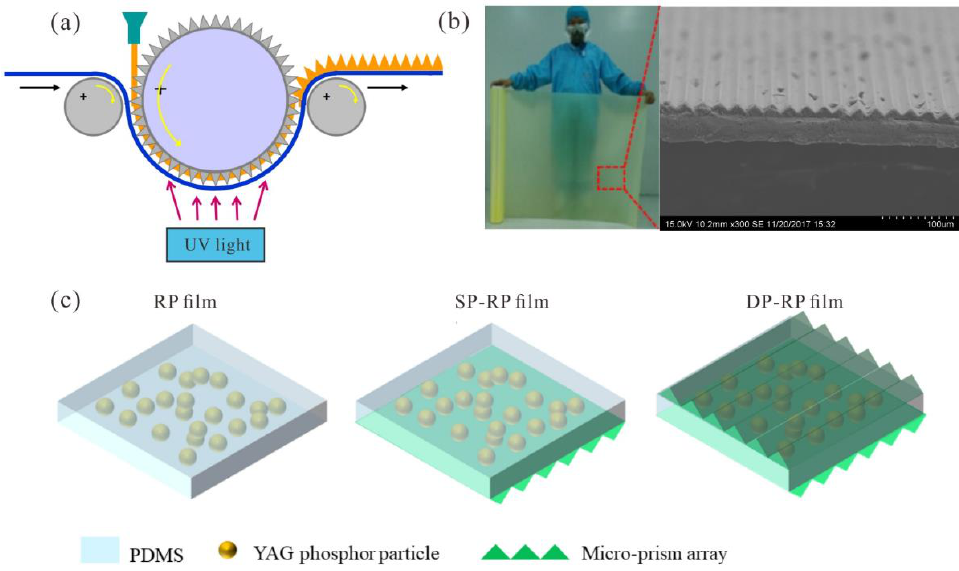
Figure 1. ( a ) Schematic diagram of roll-to-roll imprinting process; ( b ) the fabricated micro-prism film and its microstructure on the surface; ( c ) schematic diagram of three kinds of remote phosphor (RP) film, single-prism-patterned (SP-RP) film and double-prism patterned (DP-RP) film. To obtain a patterned RP film, the fabricated micro-prism film was coupled with the planar RP film by virtue of the sticky nature of PDMS with the PET substrate of micro-prism film; hence a single-prism-patterned RP (SP-RP) film and a double-prism patterned RP (DP-RP) film were obtained, which are shown in Figure 1c. As regards the DP-RP film, we arranged two micro-prism films in an orthogonal direction to circumvent the redirection of blue light in the same direction twice, which is conducive to achieving homogenous blue light distribution in the free space. In addition, the rpc-LED device configuration contained a 3535-type LED component (Foshan Nationstar), a sleeve, a total internal reflection (TIR) lens and an RP film integrated on the exit surface of the TIR lens surface. The TIR lens had a height of 7 mm and its top surface diameter was 12 mm. The phosphor film was separated by the TIR lens to form a RP configuration.